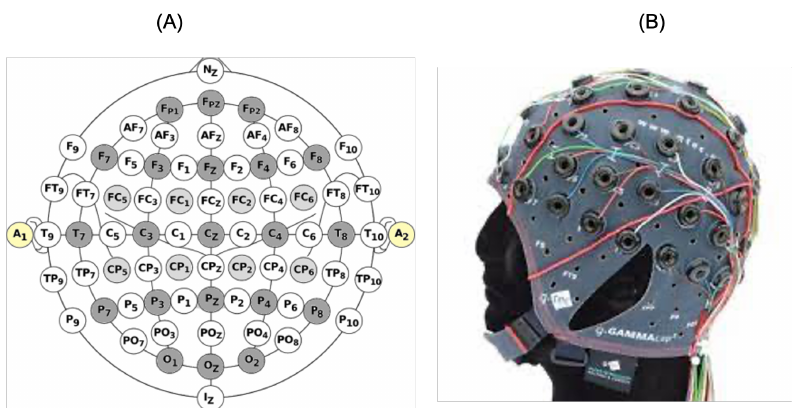
Figure 8. EEG electrode localization. ( A ) electrode positions. ( B ) g.